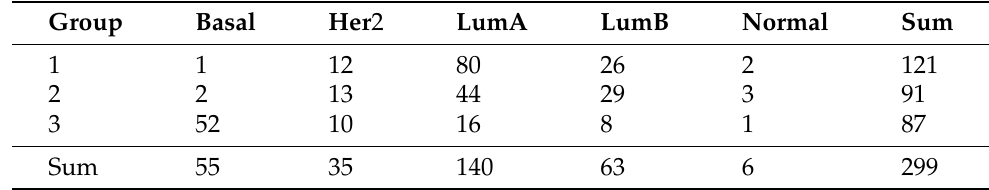
Table 1. A comparison of our approach with the PAM50 enriched BRCA subtype identified by Berger et al. [22]. Group Basal Her 2 LumA LumB Normal